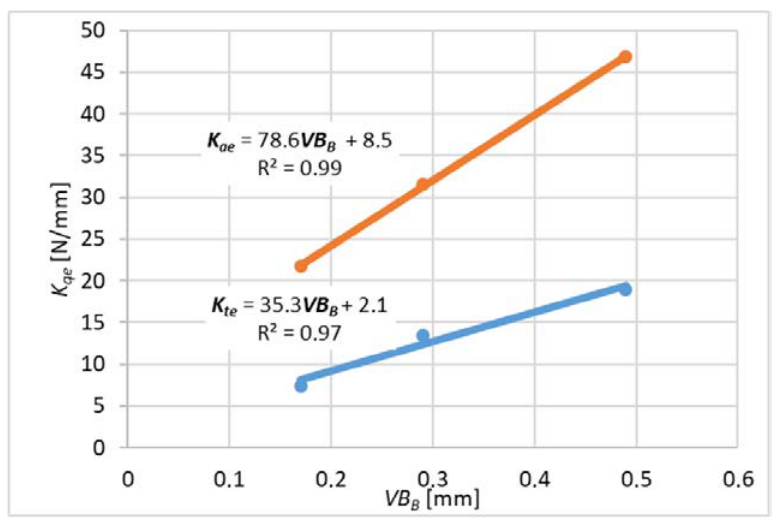
Figure 14. The Influence of tool wear on the cutting forces coefficient K e for plunge milling.